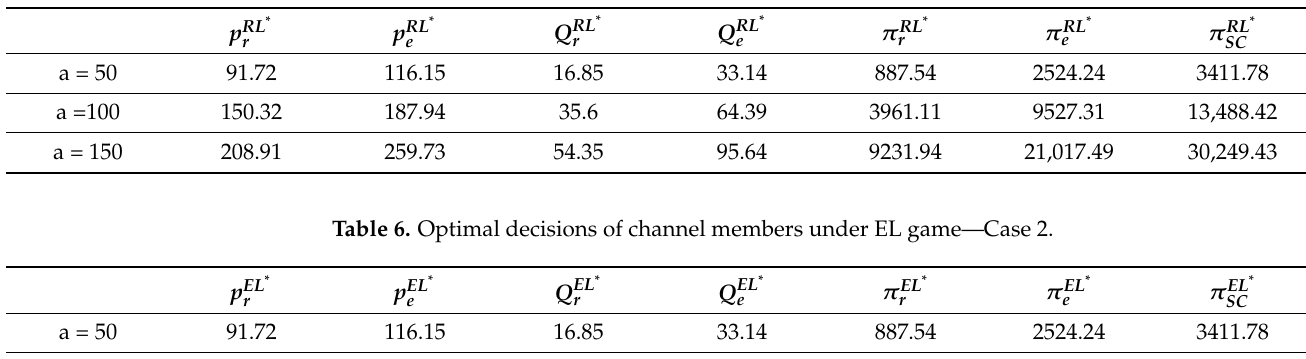
Table 5. Optimal decisions of channel members under the RL game—Case 2.